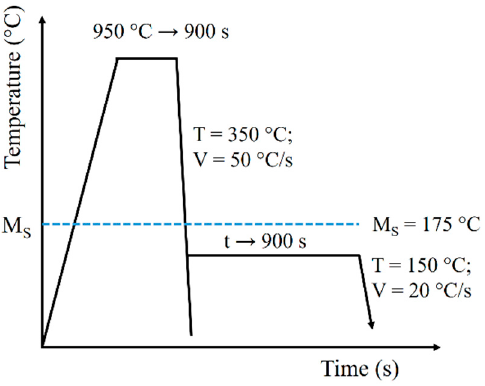
Figure 1. Schematic diagram of thermal treatment with marked recording time limits and dilato- metric measurements.